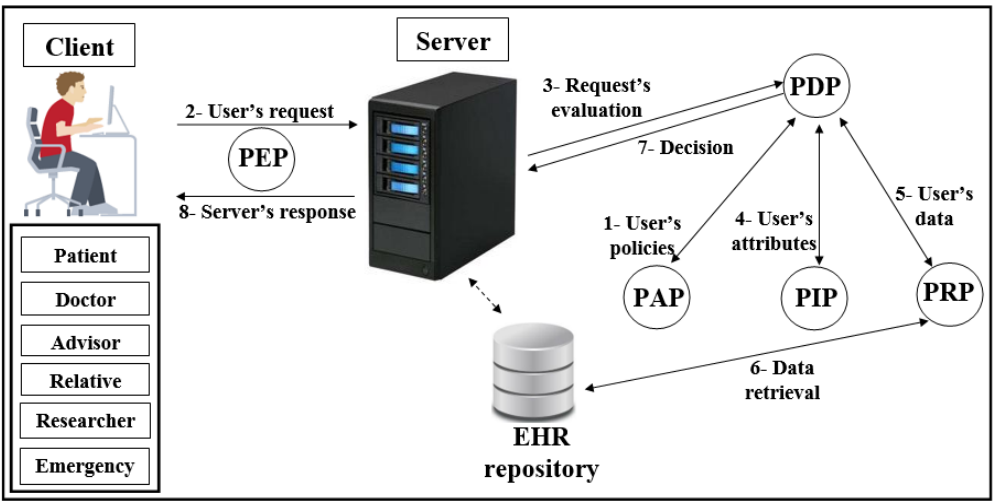
Figure 3. Scheme of